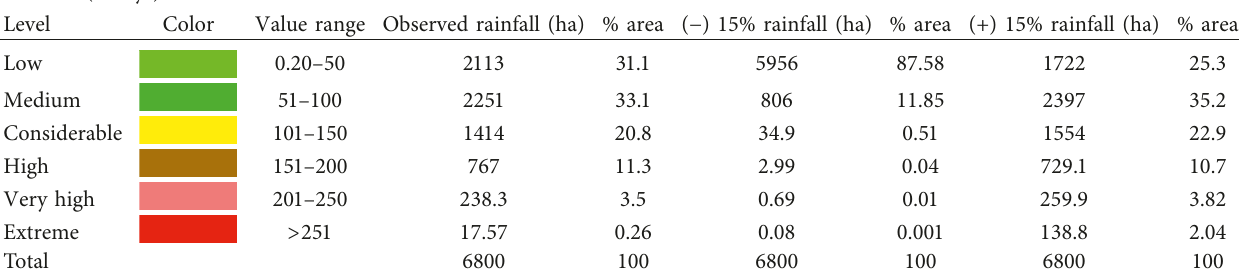
Table 2: Comparison of soil loss for the year 2019 and two scenarios with a reduction of and an increase of 15% in annual rainfall for the